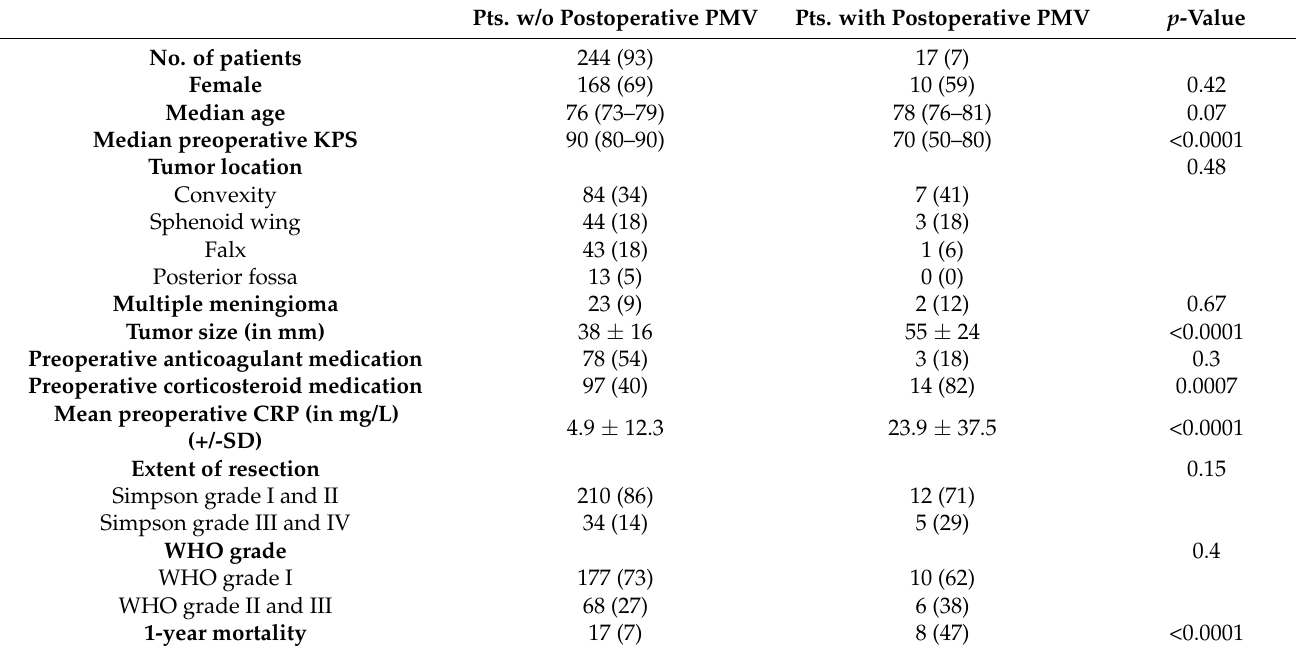
Table 3. Factors associated with PMV following intracranial meningioma resection. Pts. with Postoperative Pts. w/o Postoperative PMV PMV